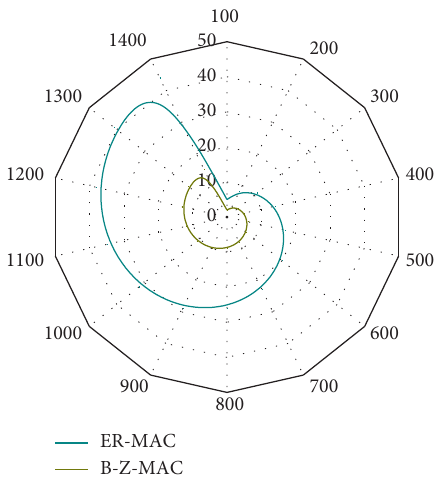
Figure 9: Comparison of energy consumption under load over